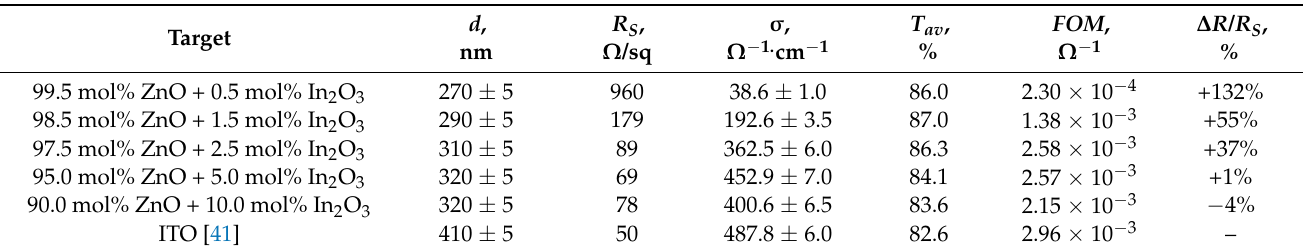
Table 2. Measured sheet resistance R S , calculated film conductivity σ = ( R S × d ) − 1 , average transmittances T av in the range of 380–760 nm, and FOM of the ZIO and ITO thin